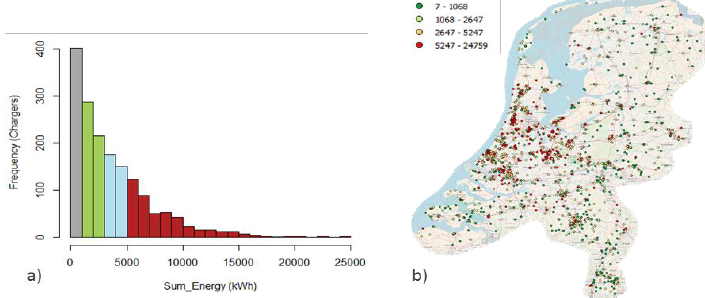
Figure 3. Histogram of energy demand per charger ( a ) and geospatial distribution of quantiles ( b